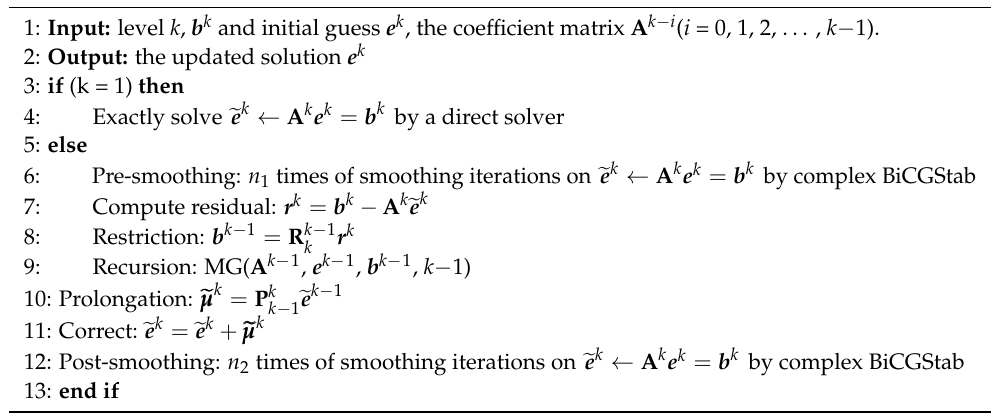
Algorithm 1. V-cycle multigrid method for the solution of A e = b : MG(A k , e k , b k , k )